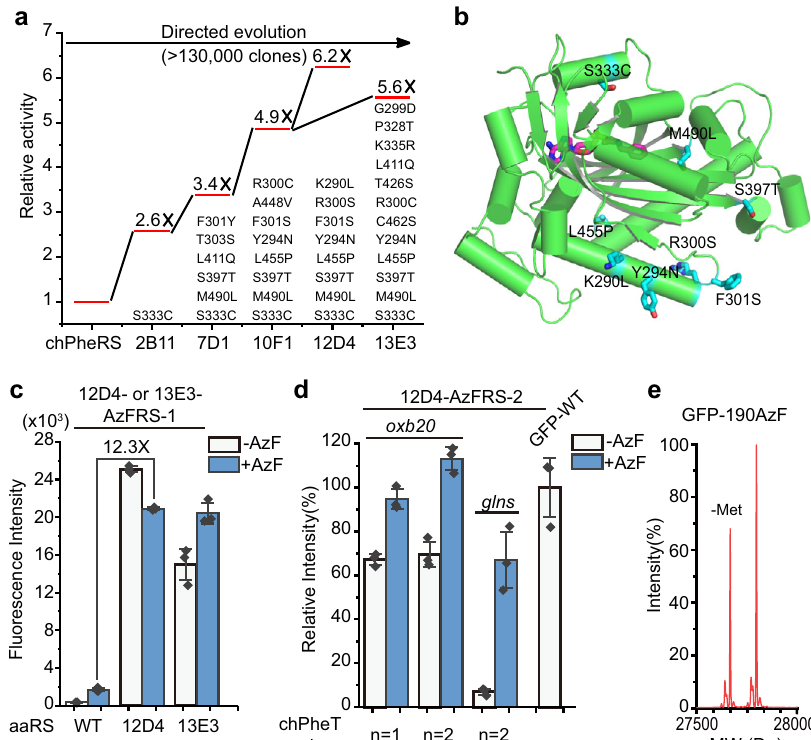
Fig. 3 Evolution of chimeric aaRSs. a Directed evolution of the chPheRS for ef fi cient genetic code expansion. The evolution trajectory of representative clones shows increased amber suppression activity compared to the progenitor chPheRS. Mutations in these representative clones are shown. b Structure of C-terminal domain of human mitochondrial PheRS, in which mutation residues in clones 12D4 are shown in sticks and phenylalanyl-adenylate in the amino acid binding pocket is highlighted in magenta. c Amber suppression ef fi ciency of the evolved 12D4- or 13E3-AzFRS-1/chPheT pairs is tested by the GFP reporter assay. d Amber suppression ef fi ciency of the evolved 12D4-AzFRS-2/chPheT pairs is tested, in which the 12D4-AzFRS-2 is under the control of oxb20 or glns promoter, respectively. e Mass spectrometry characterization of the fi delity of AzF incorporation into GFP with the 12D4-AzFRS-2/3C11- chPheT pair. The expected molecular weight (MW) 27796 Da; observed 27797Da. Error bars represents ±standard error of the mean from three biologically independent experiments. Source data are provided as a Source Data fi